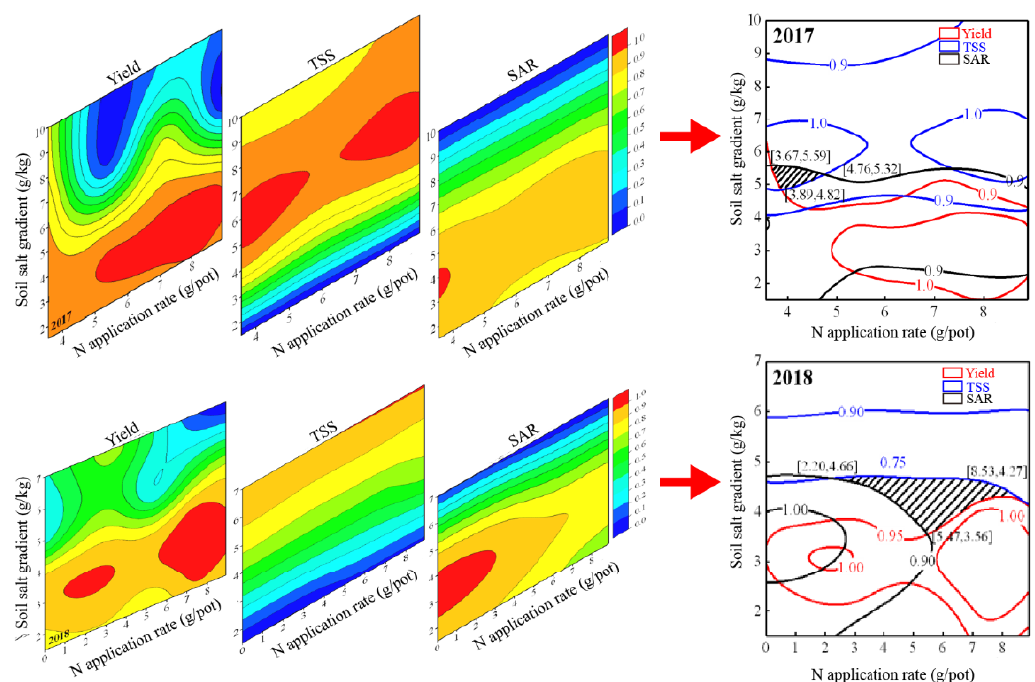
Figure 6. Data maps obtained after the normalization of yield, total soluble solids (TSS), and sugar: acid ratio (SAR), along with N application ranges and soil salinity ranges for optimum yield and quality of processing tomatoes obtained by overlapping the three distributions for each of the two years (the right most subplots). For the graphs of yield, TSS, and SAR, a value of 0 represents the conditions the most inappropriate for tomato growth while 1 represents the most suitable conditions. These three normalized figures are stacked one on another, hiding the filling area and leaving only the line of relative optimization. The triangular area surrounded by the intersection of the data lines of these three indicators is the range of N application and soil salinity under the conditions of optimal yield, TSS, and SAR.